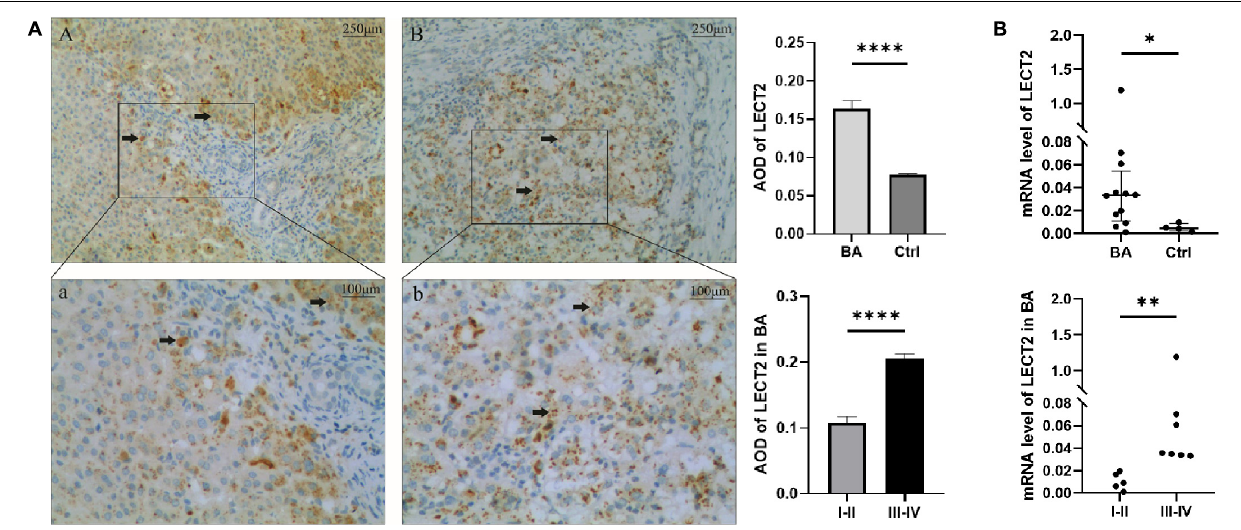
FIGURE 2 | (A) The expression of LECT2 by IHC. (B) The expression of LECT2 by qPCR. (A) The expression of LECT2 in liver tissues of patients with mild liver fibrosis (Aa) and patients with severe liver fibrosis (Bb) in the BA group by immunohistochemical staining. A and a: The black arrows point to the area of positive expression, which concentrate on the edge of portal area. (Bb) The positive expression spreads the whole hepatic lobule ( A,B, 40 × ; a,b, 100 × ). A stronger AOD was observed in the BA group than the control group. In patients with BA, a stronger AOD was observed in the severe liver fibrosis than the mild liver fibrosis. (B) Determining the LECT2 expression at the transcriptional level. The LECT2 mRNA expression in the BA group was higher than the control group, and in patients with BA, the severe liver fibrosis group was higher than the mild liver fibrosis group. LECT2, leukocyte cell-derived chemotaxin 2; AOD, average optical density; I–II, F1/F2; III–IV, F3/F4. ∗ p < 0.05, ∗∗ p < 0.01, ∗∗∗∗ p <